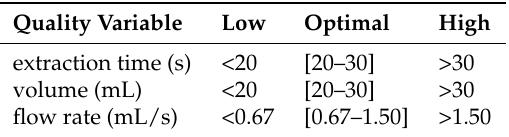
Table 2. Domain-based quality